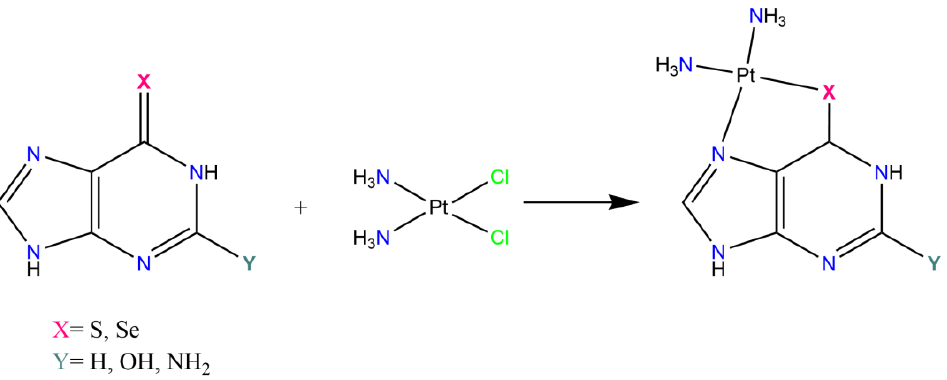
Figure 9. Schematic representation of the platinum complexes synthesized by Maeda et al.